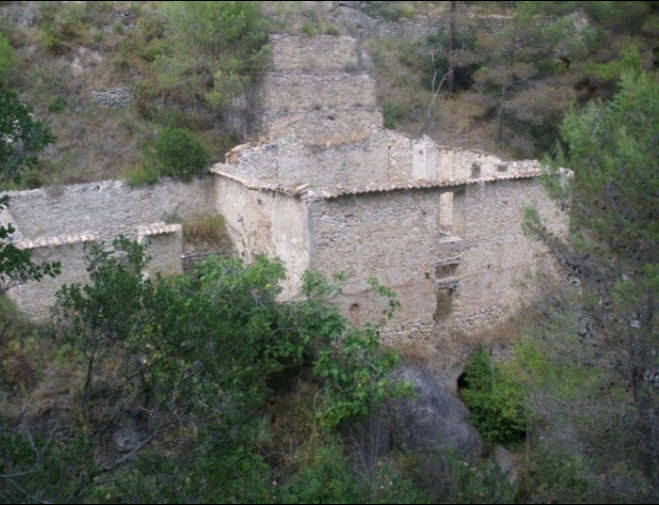
Figure 17. The tower of Rabos’ mill (Palanquetes) in Relleu (Marina Baixa, Alacant, Spain) (photo by M.A. Soler).